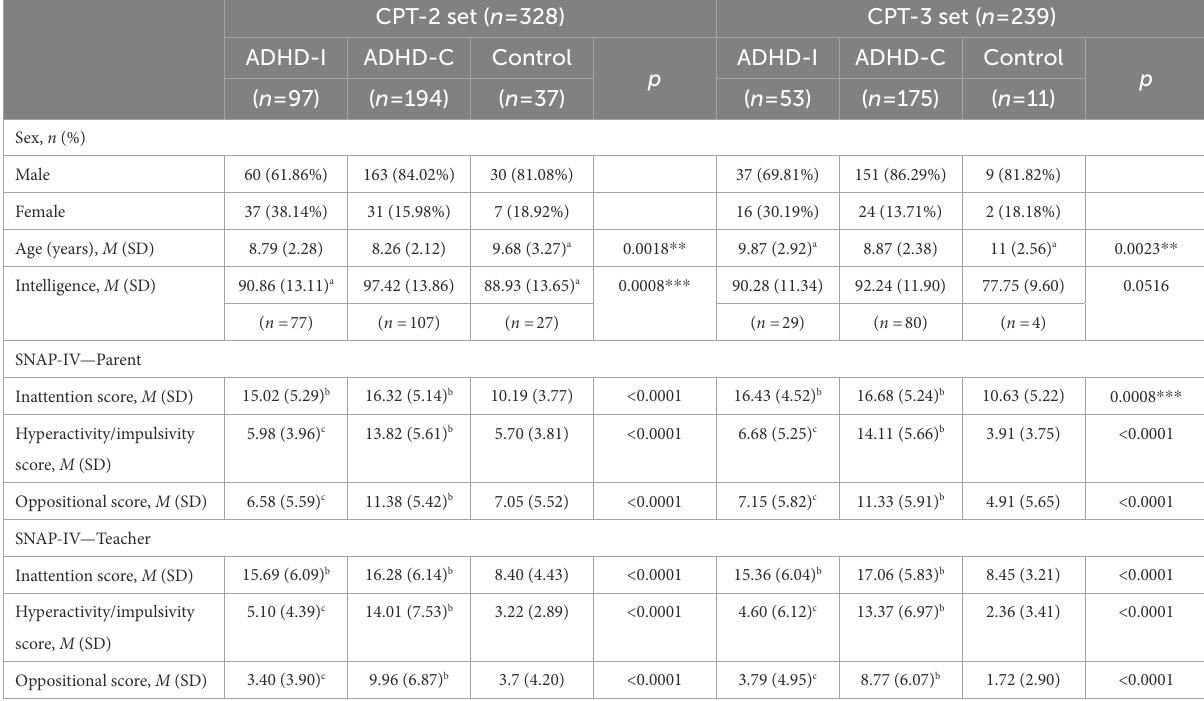
TABLE 2 Sociodemographic and clinical characteristics of individuals.